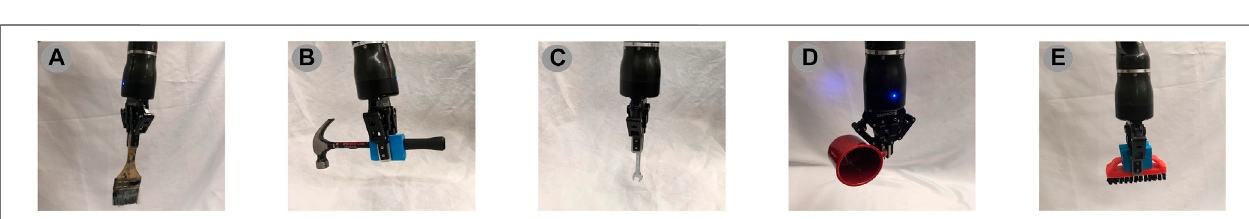
Frontiers in Robotics and AI |